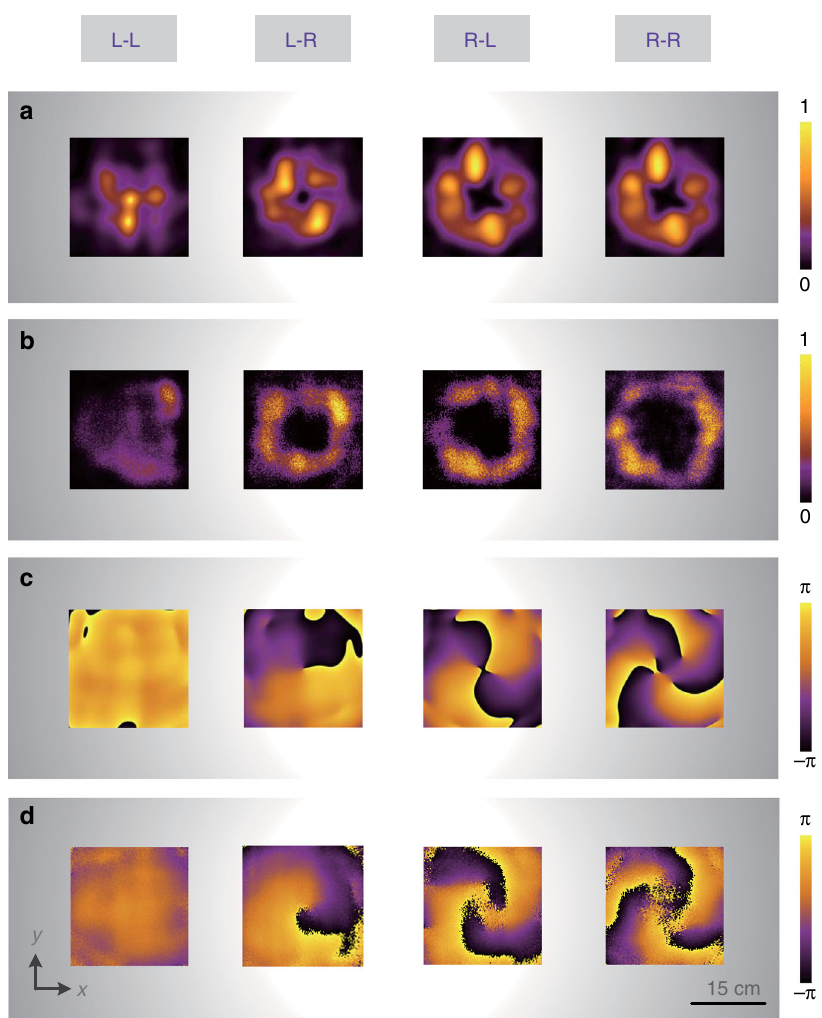
Fig. 5 Demonstration for proposed spin-to-orbital angular momentum meta-convertor. a Simulated and b measured energy intensities, and c simulated and d measured phase distributions of output vortex beams carrying different OAM modes in xoy plane with z = 150